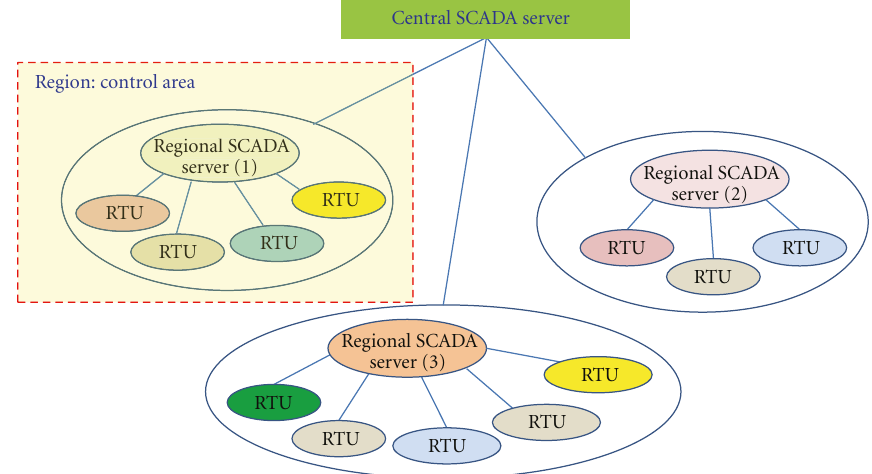
Figure 9: SCADA system configuration.